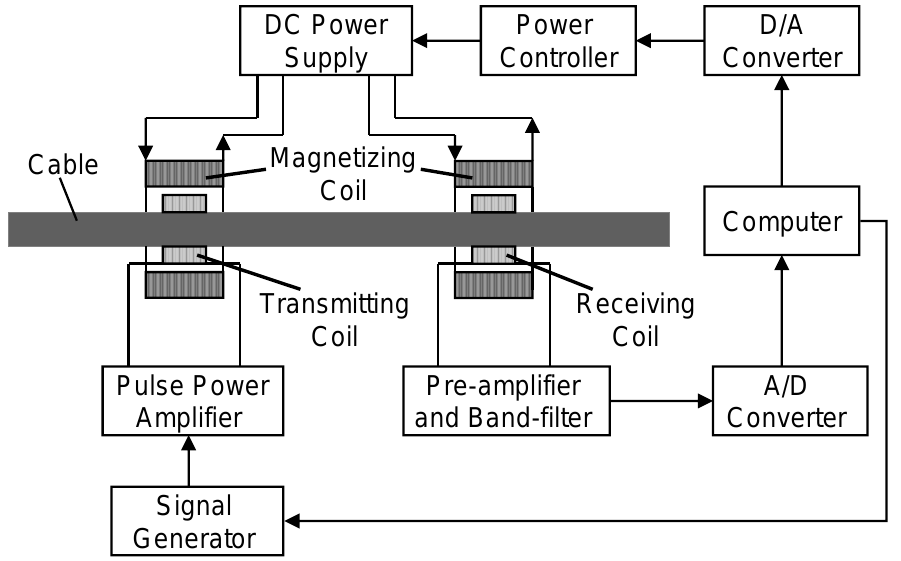
Figure 7. Schematic diagram of the experiment system for obtaining the relation of the transduction efficiency with the magnetic field